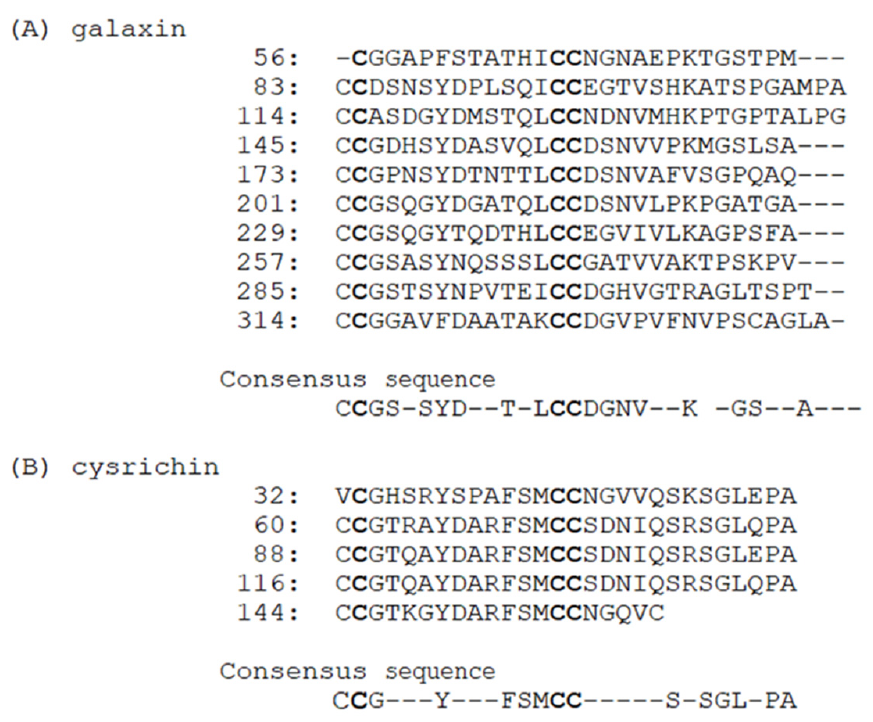
Figure 3. The tandem repeat structure in galaxin and cysrichin. Note: The information about galaxin was obtained from the study of Fukuda et al. [14], GenBank Accession No. AB086183. The galaxin protein was isolated from coral Galaxea fascicularis . Numbers on the left indicate the position in the predicted protein, and “ − ” represents an arbitrary amino acid. The consensus sequence for the repeats from each protein is shown beneath the alignments.